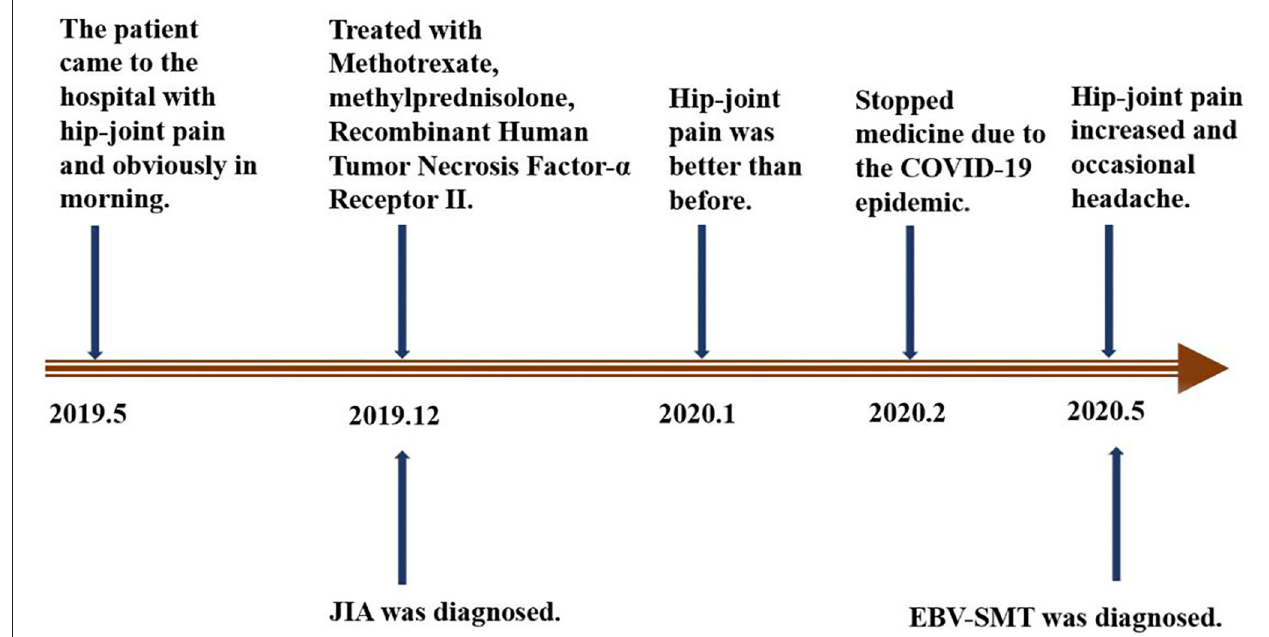
FIGURE 1 | Diagram of the disease